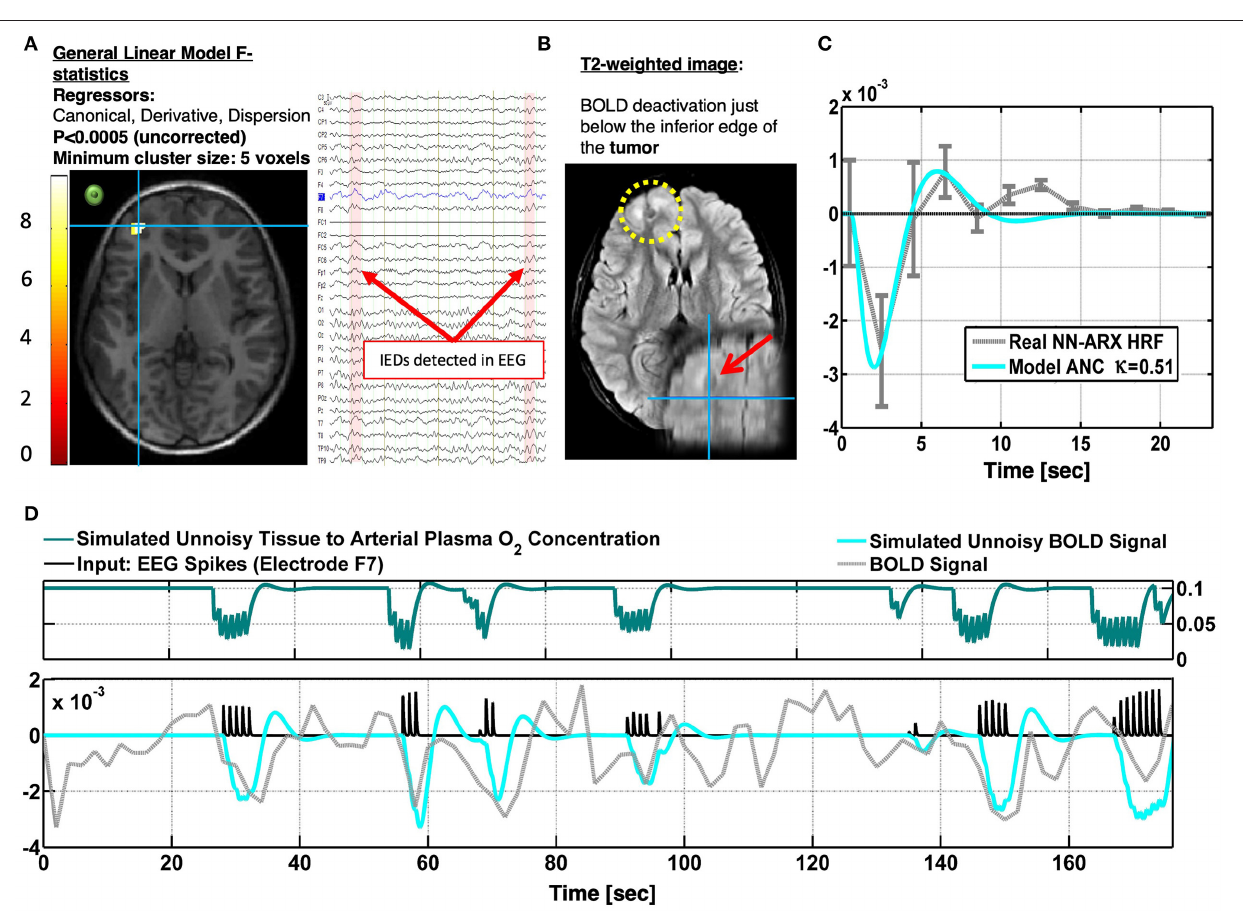
FIGURE 7 | Patients #4 shows an irritative zone with ANC-type HRF in a brain area at the edge of a tumor (TSC). (A) Axial slice of the thresholded F-statistics map built from the estimated coefficients of the GLM overlaid on the T1-weighted image. The IEDs were detected using the EEG signal in electrode F7. The approximate location of this electrode is shown with a green circle to illustrate the possible relation between the NBR region and the IEDs. The right inset shows a short segment of the preprocessed EEG data where 2 IEDs were identified. (B) The patient suffers from tuberous sclerosis complex. The cyan crosshair—the maximum value of the F-statistics—locates the center of the NBR region, in the perimeter and below one of the patient’s tumors. The tumor is highlighted with the yellow circle in the axial slice and the red arrow in the coronal slice of the T2-weighted image. (C) The gray curve shows the estimated NN-ARx HRF and its confidence interval, estimated from the real data, and averaged across the voxels within a 10 mm-radius sphere with origin in the crosshair in (A) . The cyan curve shows the unnoisy simulated HRF of the fitted OTT model with the estimated value of the neuro-metabolic coupling gain: κ = 0.51 s − 1 . (D) For illustration purposes, we also show the simulated temporal behavior of the state variable g and the simulated BOLD in the NBR region [with κ = 0.51 s − 1 ], the time series of the real fMRI and the input. To account for the actual relative effect of the IEDs, the amplitude of the input pulses was multiplied by the normalized power of the EEG in